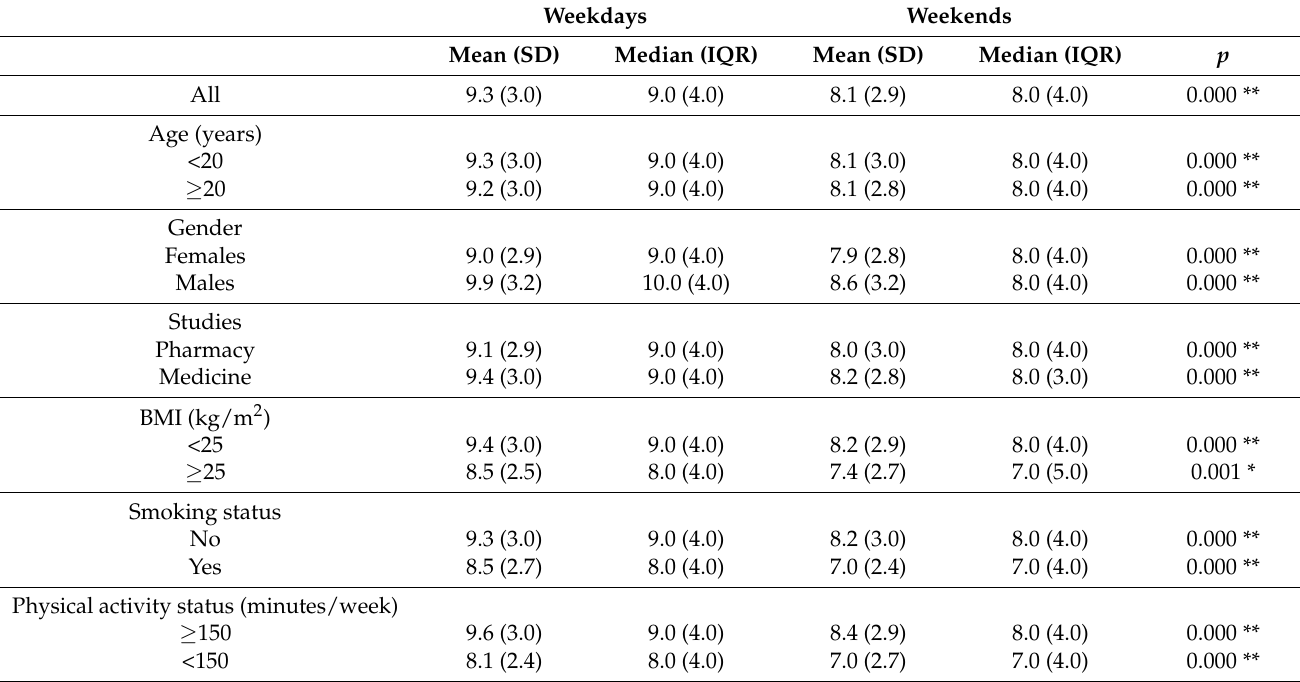
Table 4. Scores of the AMD index (weekdays–weekends).